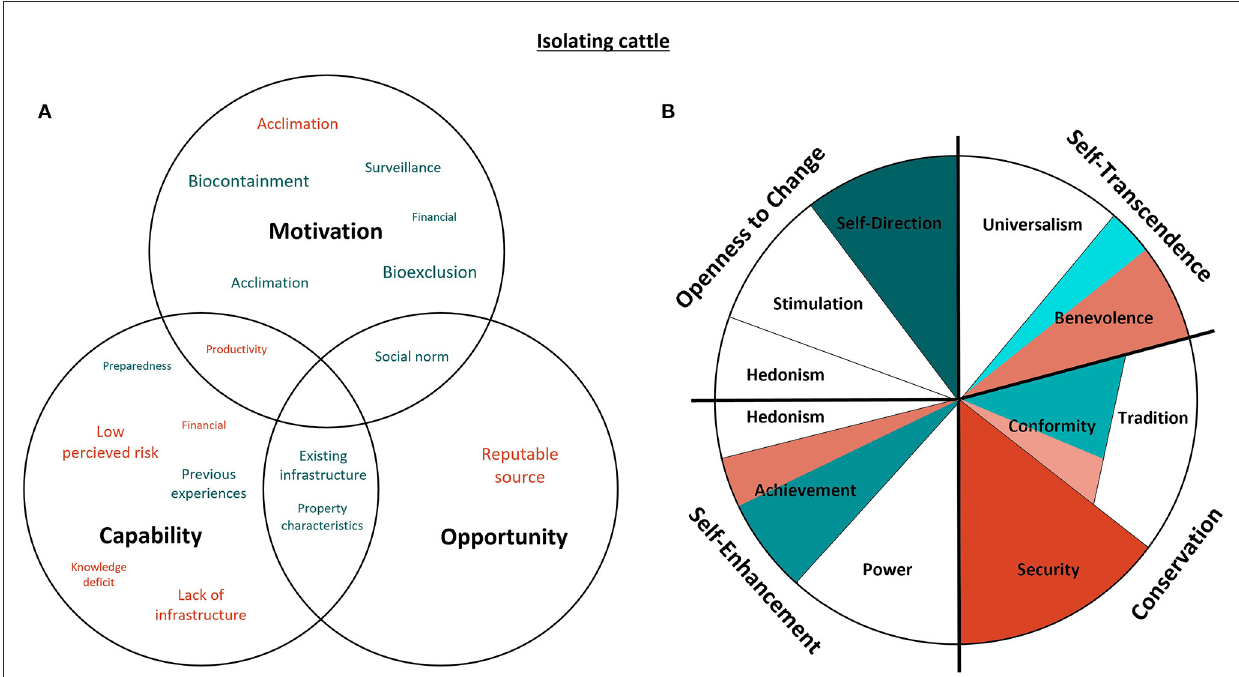
FIGURE5 Capability, opportunity, motivations and values associated with isolation of introduced cattle. Green represents attributes that promote the desired behavior, while red indicates confounding attributes. The size of the text in (A) indicates the commonality of themes amongst the participants, as does darker shading in (B) [adapted from Schwartz (29). CC BY-SA 4.0]. Values with both green and red shading both promote and confound desired isolation